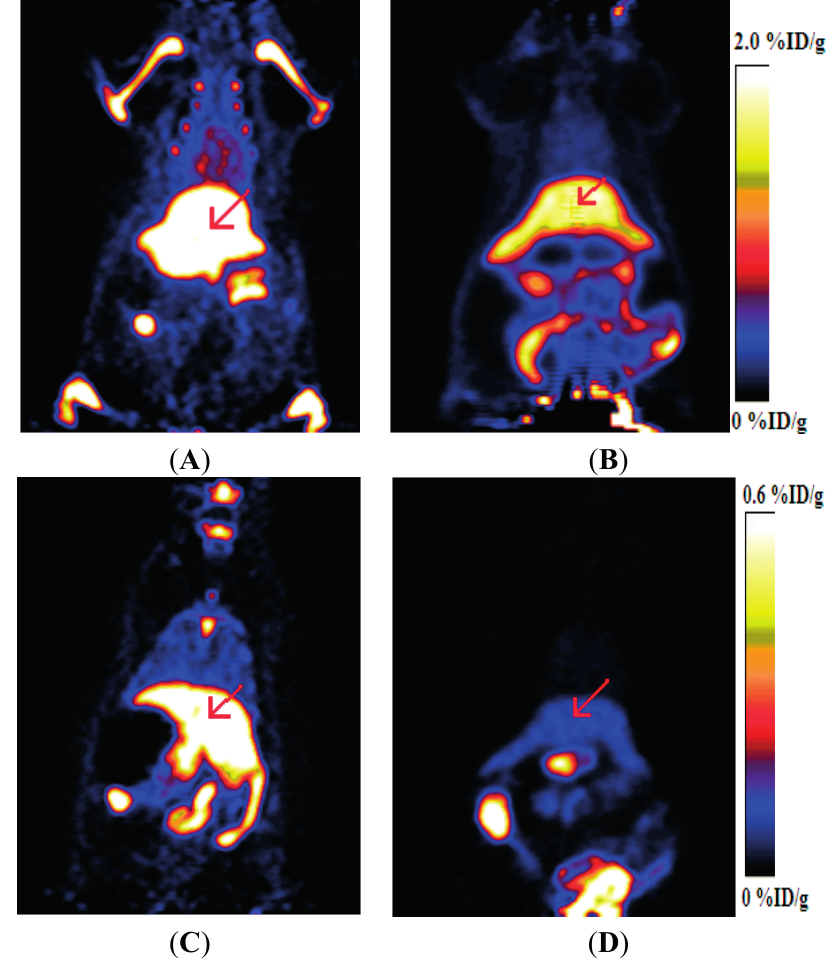
Figure 5. MicroPET images of CHX-treated and normal rats after injection of 18 F-FBEM-Cys-Annexin V. ( A ) CHX-treated at 1 h p.i. ( B ) Normal at 1 h p.i. ( C ) CHX-treated at 2 h p.i. ( D ) Normal at 2 h p.i.